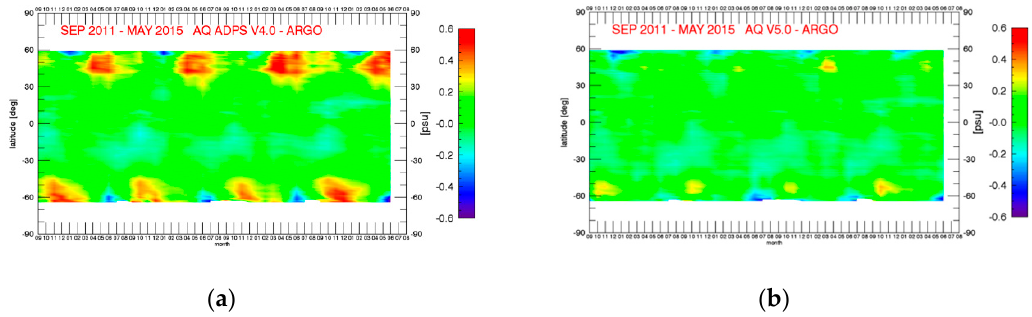
Figure 13. Hovmoeller plot of the difference between Aquarius and Scripps ARGO salinity. Panel ( a ) is for the Version 4 release. Panel ( b ) is for the Version 5 release. The x-axis in both plots is the time (month) over the time period September 2011–May 2015. The y-axis is the latitude. For the comparison Aquarius observations containing rain have been discarded (see Section 2.2.6).